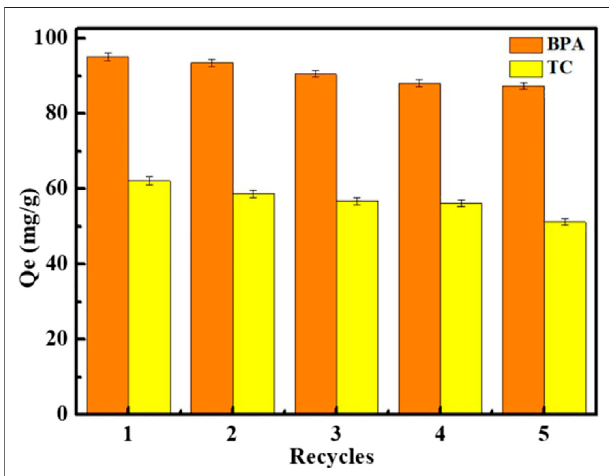
FIGURE 8 | Qc (mg/g) of BPA and TC after fi ve